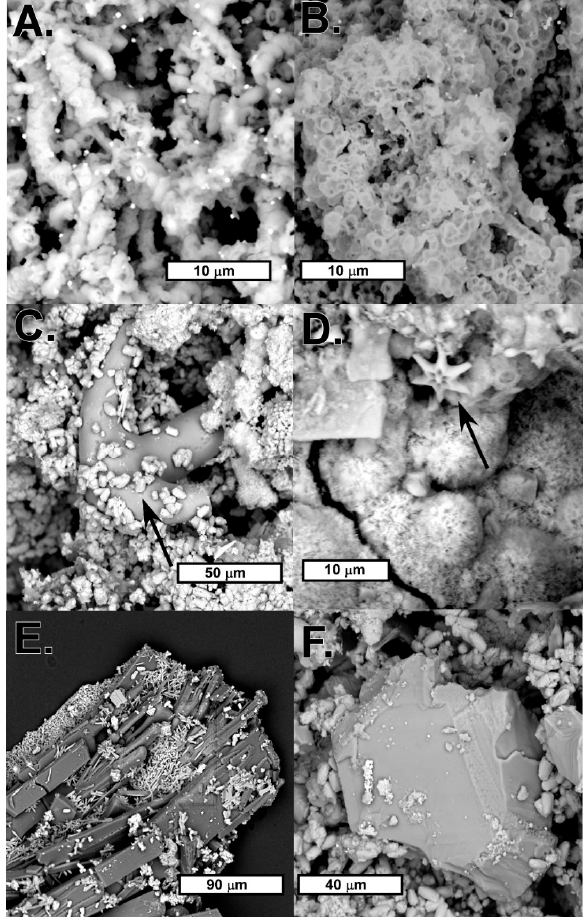
Figure 6. SEM images of features from black crusts. ( A , B ) Cell-like forms from the middle crust, ( C , D ) remains of microscopic marine life embedded within black crusts (highlighted by arrows), ( E ) calcium sulfate crystals (grey) with sodium carbonate overgrowths (white), and ( F ) a conchoidally fractured sand grain (center of image).